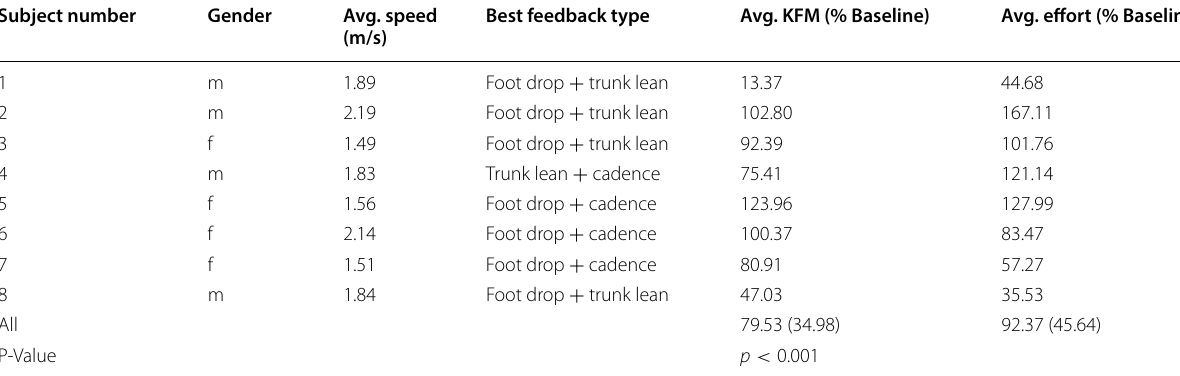
Table 3 Results for all subjects by multiple feedback type